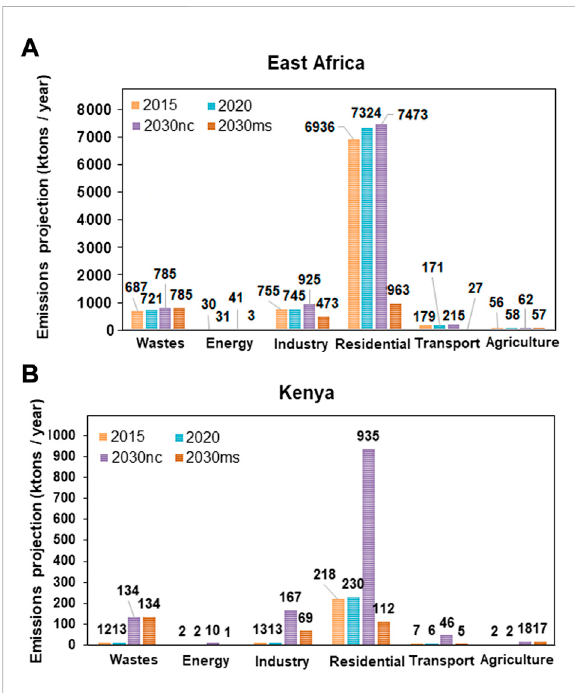
FIGURE 4 Annual ECLIPSE projected emissions of PM 2.5 for (A) East Africa and (B) Kenya, according to the geographical extent shown inFigure 2.The emissions are relativeto theCLEcases of2015